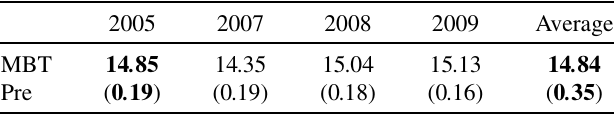
TABLE IV. Performance of MIT 8.01 students on precourse administration of the MBT. Our participants were part of the 2005 cohort (shown in bold).